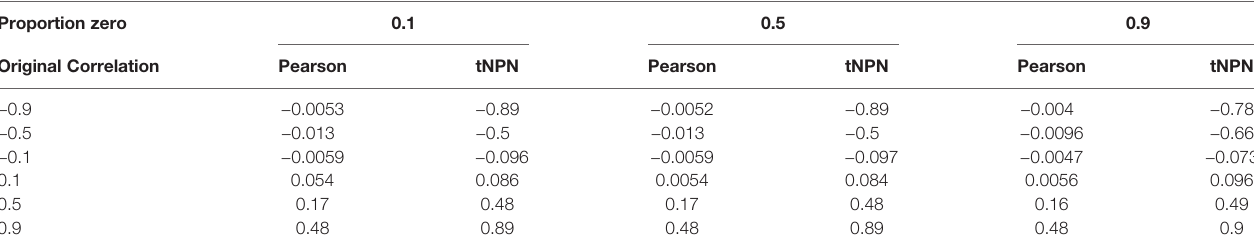
TABLE 2 | Effect of different levels of sparsity (proportion of zeros) in the form of truncation on the standard Pearson (sample) product-moment correlation coef fi cient and the truncated non-paranormal correlation estimate ^ S